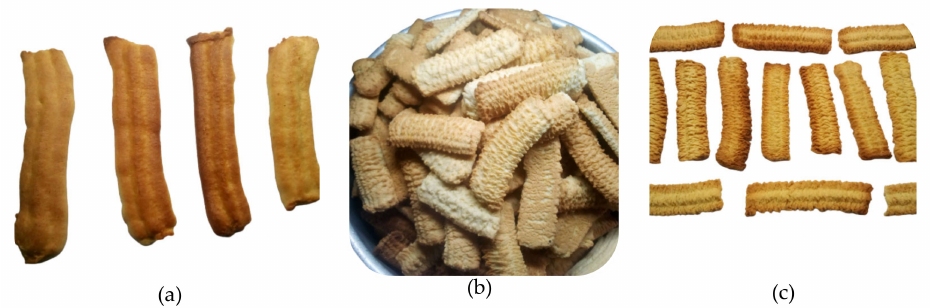
Figure 7. Processed biscuit samples. ( a ) Baked biscuits treated with baker’s yeast powder, ( b ) Baked biscuits treated with asparaginase enzyme, ( c ) Baked biscuits treated with green tea